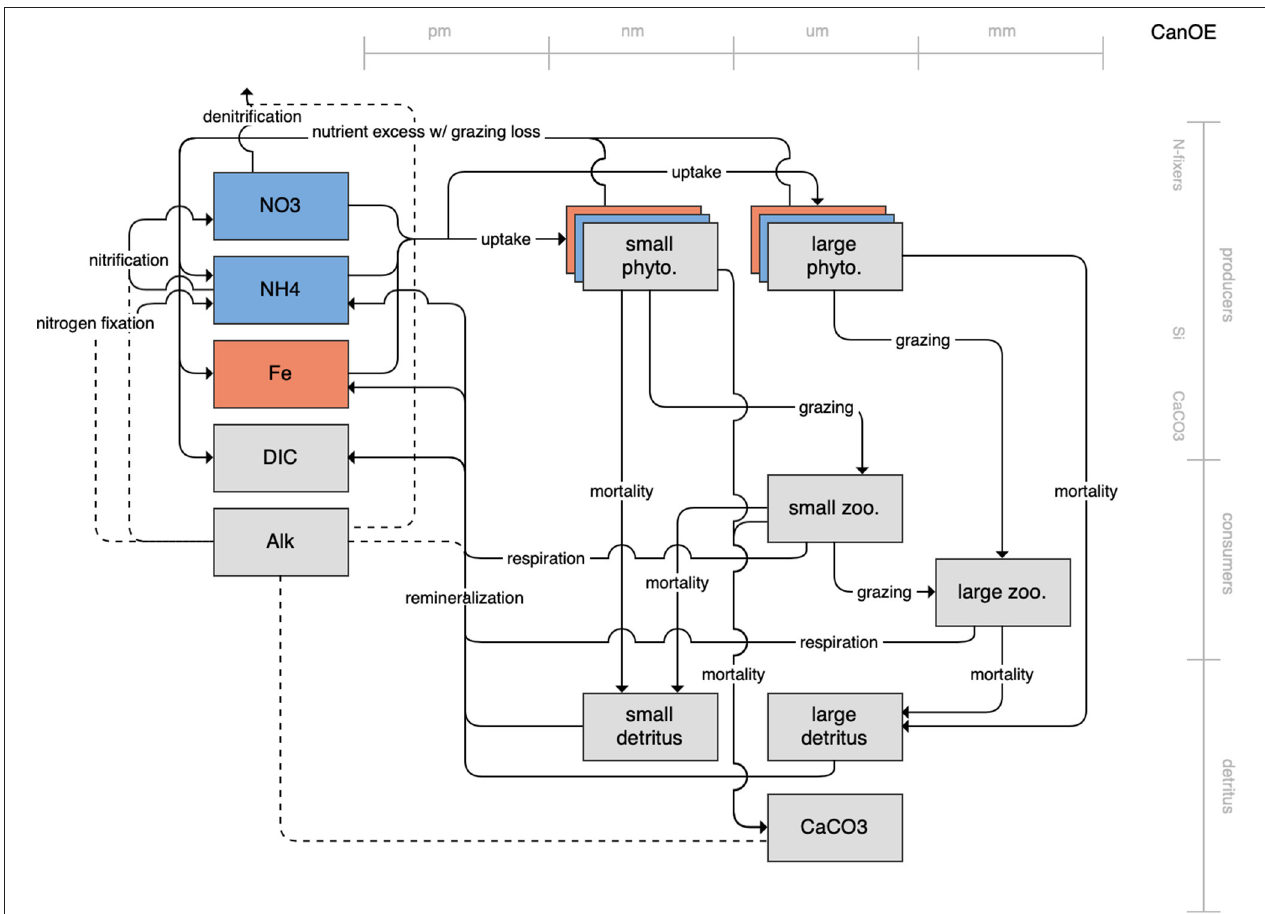
FIGURE 9 | Schematic for the CanOE model. See Figure 1 caption for